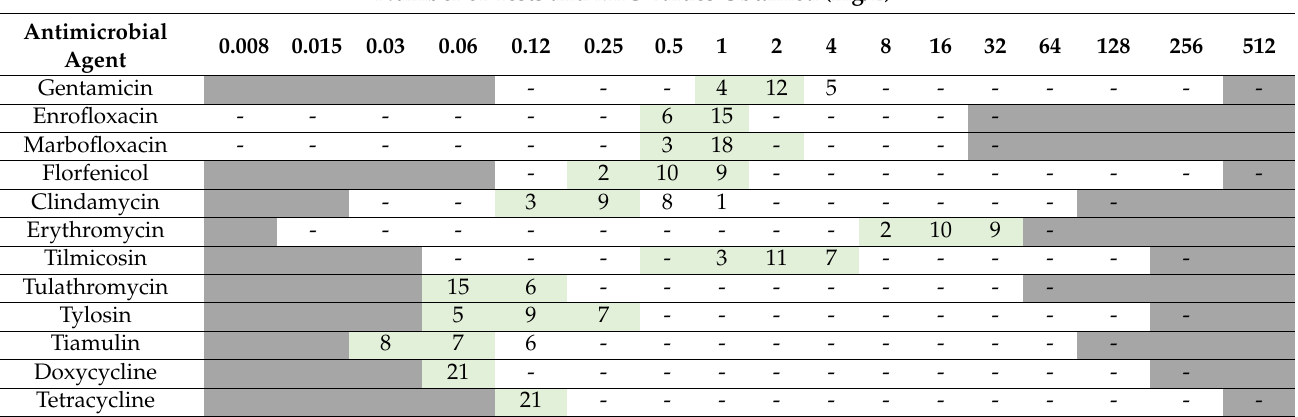
Table 4. Distribution of the MIC values for M. hyorhinis DSM 25591. Twenty-one individual test results containing all tested batches and the respective controls are shown. For reasons of better comparability, the initial ranges of MIC results, given in Table 2, are highlighted in